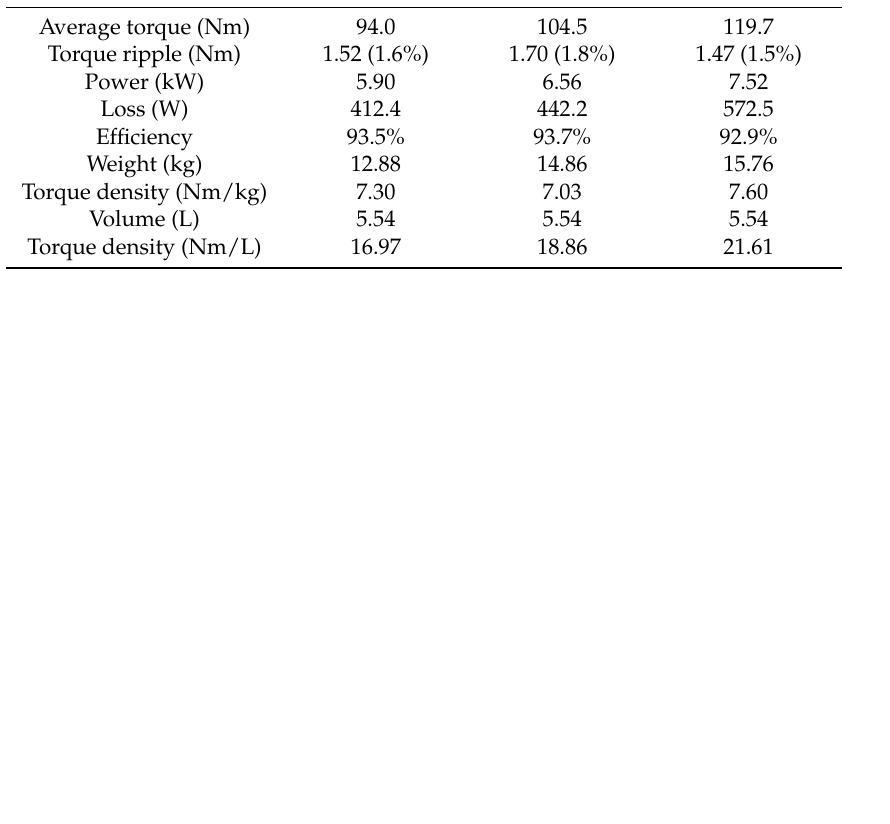
Figure 6. 3D magnetic flux density vector diagram at no-load condition. ( a ) M II. ( b ) M III.